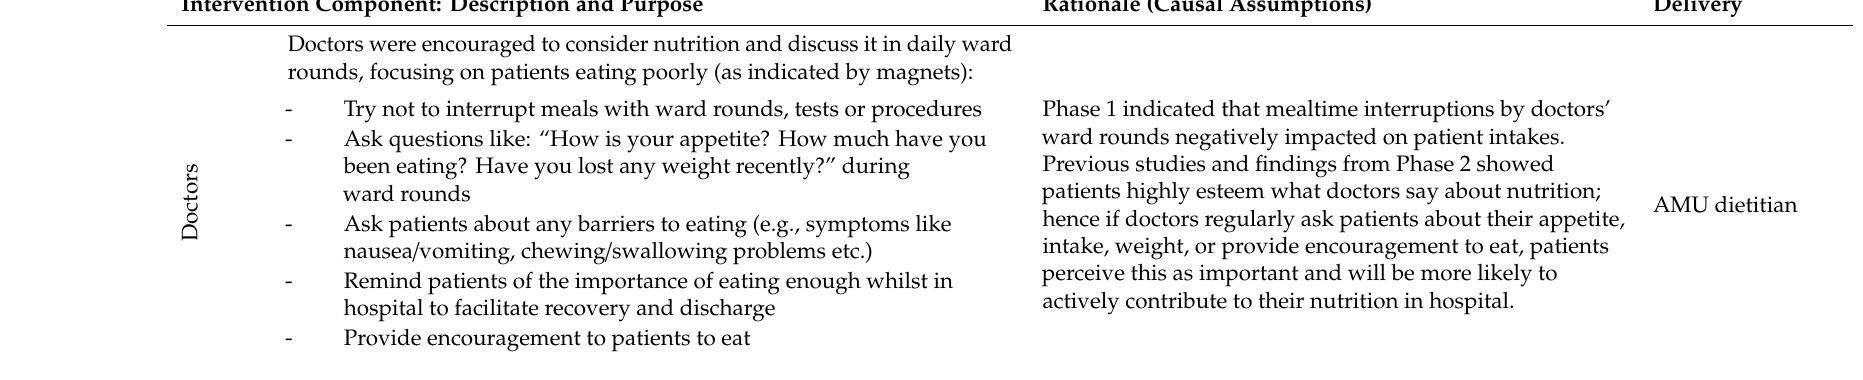
Intervention Component: Description and